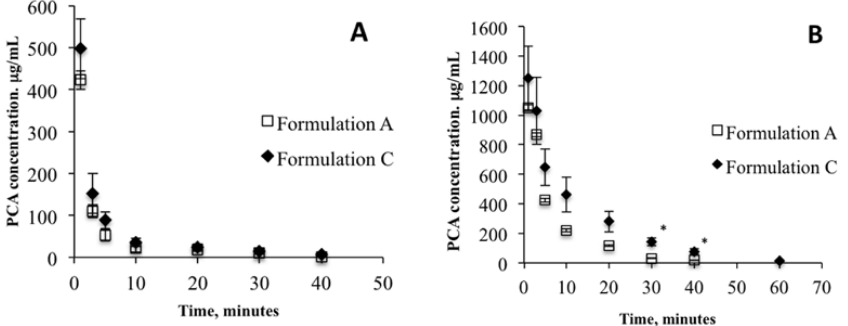
Figure 2. Concentration of PCA in tear fluid of rabbits after administration of 50 µL ( A ) and 100 µL ( B ) of the formulations under study. Means ± SE., n = 6. * Statistically significant different, ( p < 0.05, t - test). Table 3. Pharmacokinetic parameters in tear fluid after topical administration of the formulations under study. Means ± SE, n = 6.